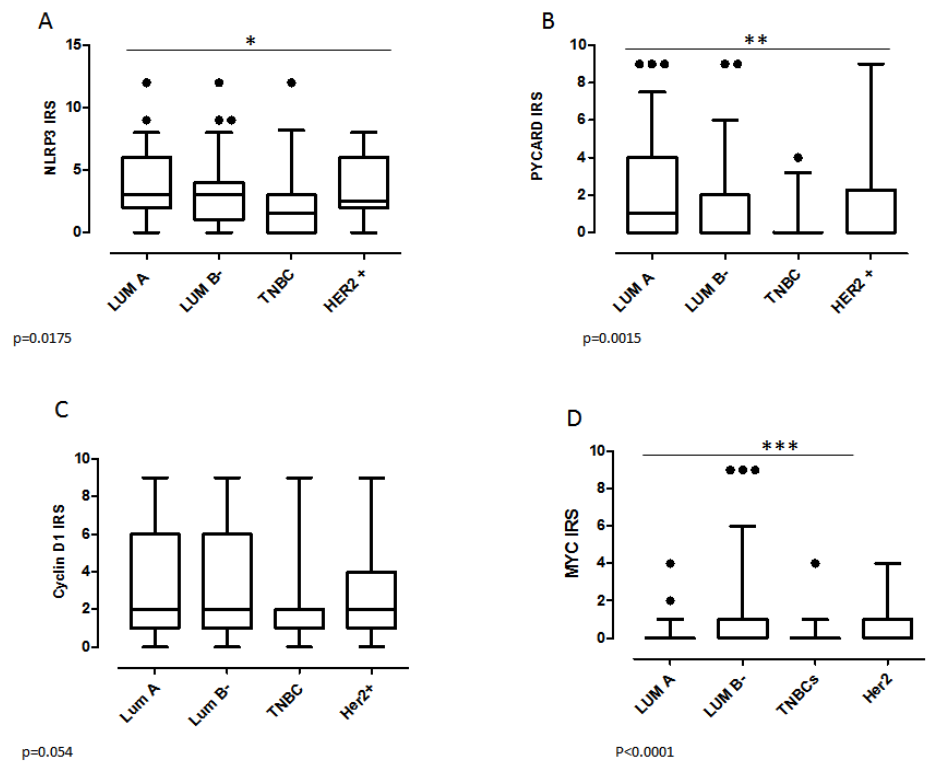
Figure 2. Protein expression level in the different molecular BC subgroups. ( A ) NLRP3 expression. ( B ) PYCARD expression. ( C ) CyclinD1 expression and ( D ) MYC expression by Anova test. IRS: Immuno Reactive Score. The IRS was calculated by the product of the proportional score (PS) obtained from the percentage of positive cells and the intensity of the staining (see materials and methods section). Values are expressed as a median (horizontal bold line in each box), dot indicates outliers. * p < 0.05; ** p < 0.01; *** p < 0.001.